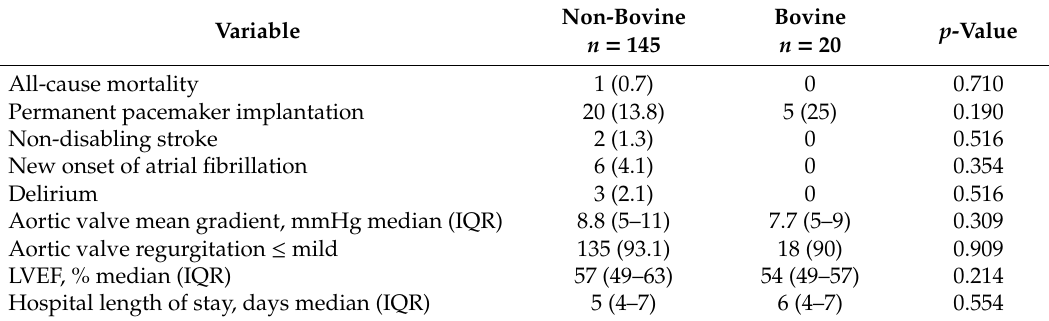
Table 3. In-hospital